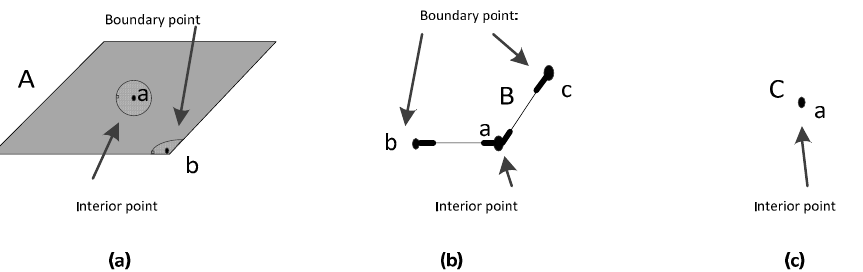
Figure 3. Spatial objects in 2D space and their boundary points and interior points based on manifold topology. ( a ) Simple region (2-manifold) in R 2 , its interior point has a neighbourhood homeomorphic to R 2 , its boundary point has a neighbourhood homeomorphic to H 2 ; ( b ) Simple line (1-manifold) in R 2 , its interior point has a neighbourhood homeomorphic to R 1 , its boundary point has a neighbourhood homeomorphic to H 1 ; ( c ) Simple line (0-manifold) in R 2 , its interior point has a neighbourhood homeomorphic to R 0 , it has no boundary point.